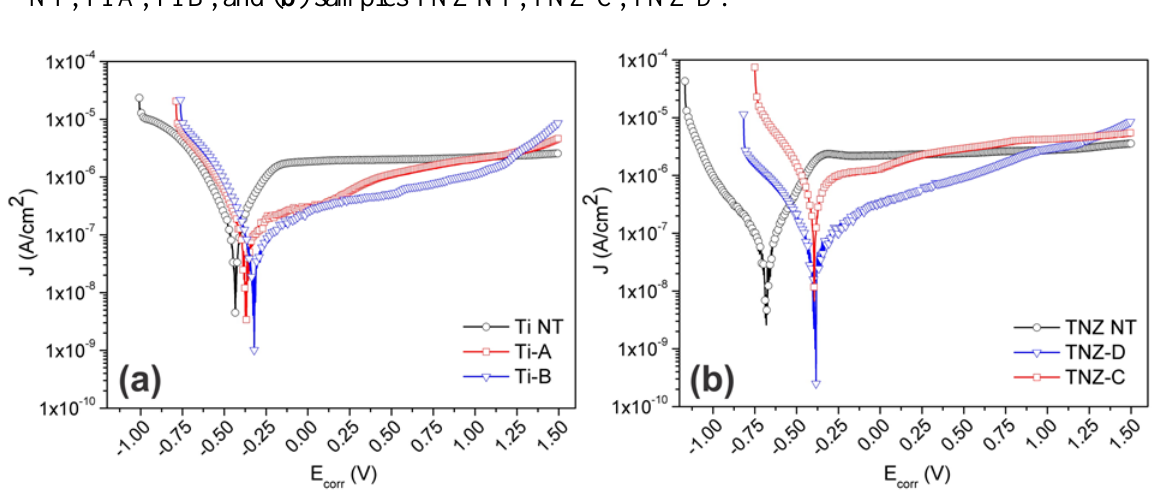
), corrosion potential ( E ), corrosion current density OCP corr and E values are within ±0.005 V, whereas OCP corr